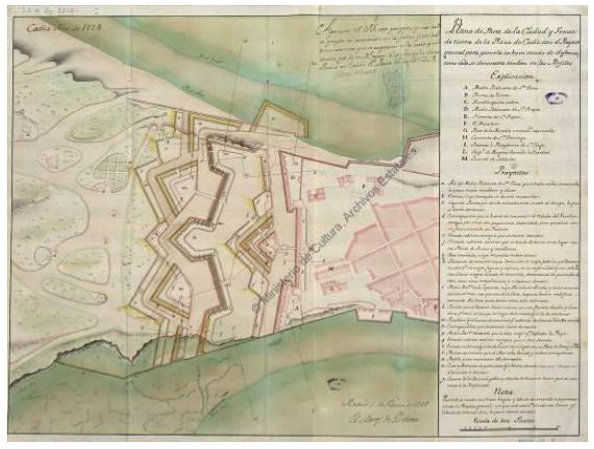
Figure 7. General project “to put in good condition” the Puerta Tierra over Cadiz in 1724. Year 1728. Marquis of Verboom. AGS, Secretary of War, file, 03626. Signature MPD, 29,008.